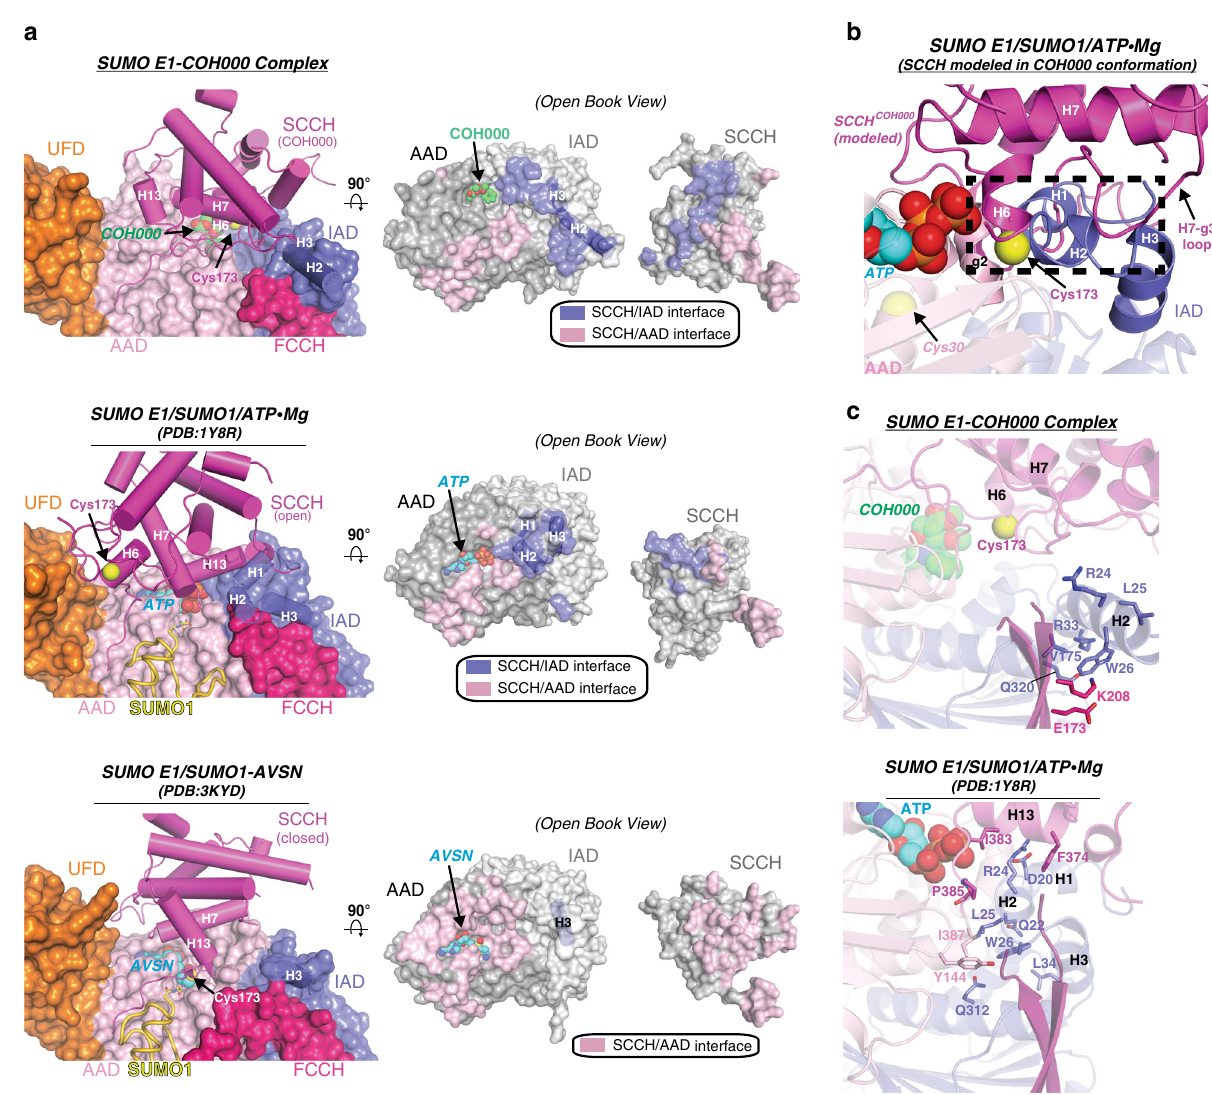
Fig. 4 COH000 exploits allosteric coupling of the SUMO E1 adenylation and SCCH domains. a (left) The adenylation domains and UFD of the indicated structures are shown as surface representations and the SCCH domains are shown as cartoons. The SUMO E1 catalytic cysteines, COH000, ATP, and AVSN are shown as spheres. a (right) Open book representation of the indicated structures shown in a top-down view relative to the left panel. Residues buried at the IAD/SCCH and AAD/SCCH interfaces are colored slate and pink, respectively. b The SCCH domain is modeled onto an adenylation active SUMO E1 COH000 structure in the COH000-inhibited conformation. The model was created by superimposing the adenylation domains of the SUMO E1 COH000 and SUMO E1/SUMO1/ATP (cid:129) Mg (PDB: 1Y8R) structures. The SUMO E1/SUMO1/ATP (cid:129) Mg structure is shown as cartoon, and the SCCH domain is not shown for clarity. Only the SCCH domain from the SUMO E1 COH000 structure is presented (as a cartoon). The SUMO E1 catalytic cysteine (Cys173), Cys30, and ATP are shown as spheres. Regions involved in steric clashes between the adenylation domains and the SCCH domain modeled in the COH000 conformation are highlighted with a dashed black box. c The indicated structures are shown as cartoon representations. The RLW motif of the Sae1 IAD and SUMO E1 residues involved in contacts to the RLW motif are shown as